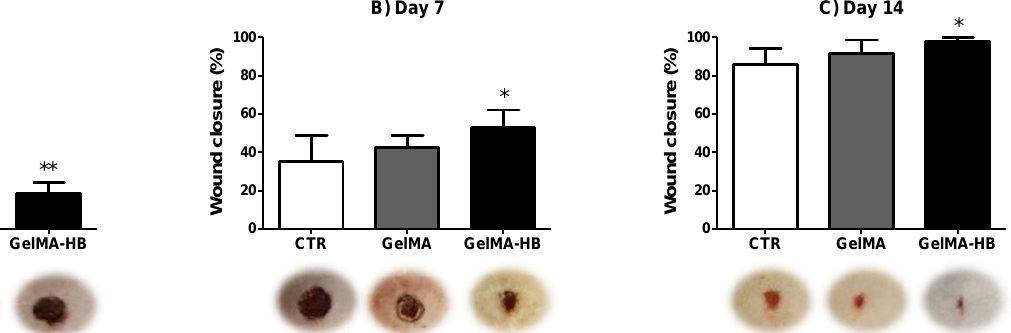
Figure 2. Characterization of GelMA hydrogels. ( A ) Mechanical properties—maximal strain in compression mode (*** p < 0.001); ( B ) Mechanical properties—Young modulus in compression mode (*** p < 0.001); ( C ) Swelling index (** p < 0.01). All values expressed as mean ± standard deviation. Two-tailed t -test ( α = 0.05).